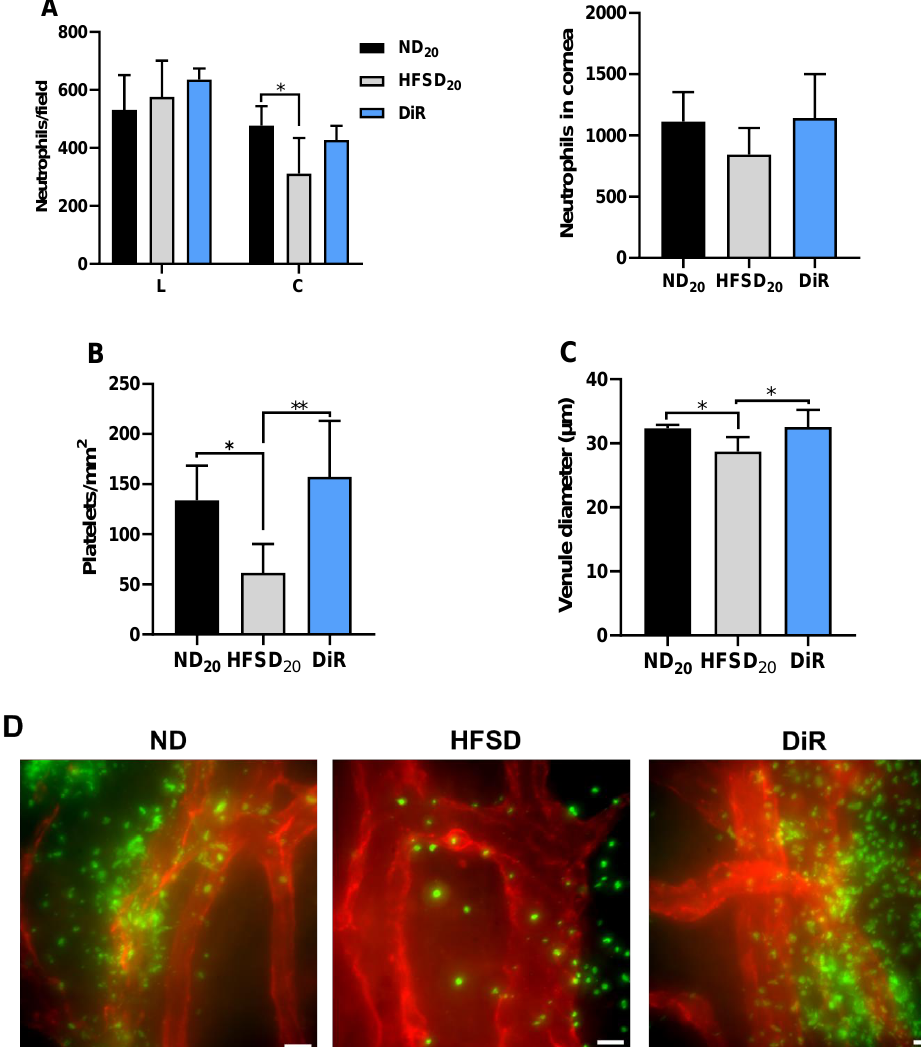
Figure 8. Diet reversal restored normal abrasion-induced inflammation. ( A ) Left: The distribution of neutrophils over the limbus and center of the cornea 30 h after wounding. Right: Sum of neutrophils in four fields of view of the cornea (periphery, parawound, paracentral and center) at 30 h after wounding. ( B ) Platelets count at the limbus 30 h after wounding. ( C ) Diameter of venules at the corneal limbus. ( D ) Representative images of platelets at the limbus; images captured with a 60X oil objective lens (scale bar = 15 µm). Data expressed as means ± SD; ND 20 —20-week normal diet; HFSD 20 —20-week high-fat/sucrose diet; DiR—diet reversal; L—limbus; C—center * p ≤ 0.05, ** p ≤ 0.01. Scale bars: D = 15 µm.